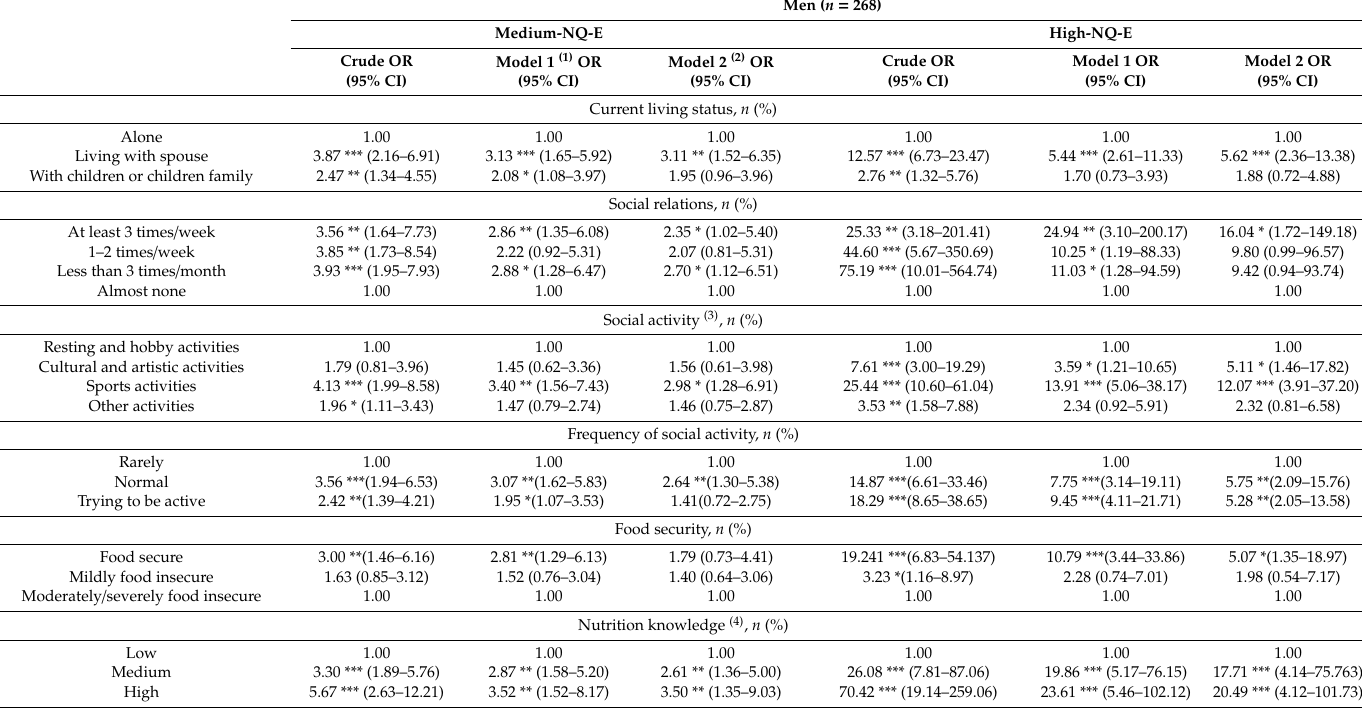
Table 6. Multinomial logistic regressions of an association between living environmental factors and NQ-E levels in elderly